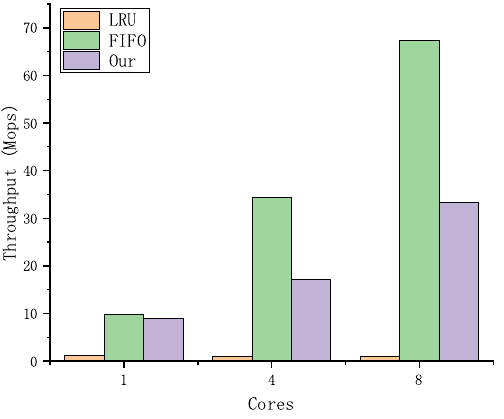
Figure 11. Throughput at 70% put operation and 30% get